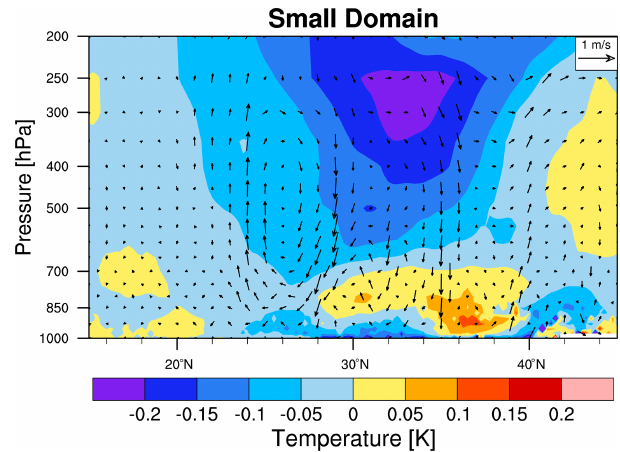
Figure 11. The latitude-pressure cross section of aerosol-induced difference (CTRL-CLEAN) of temperature and wind averaged be- tween 105 and 122 ◦ E for June and July 2017 from the small- domain simulation.